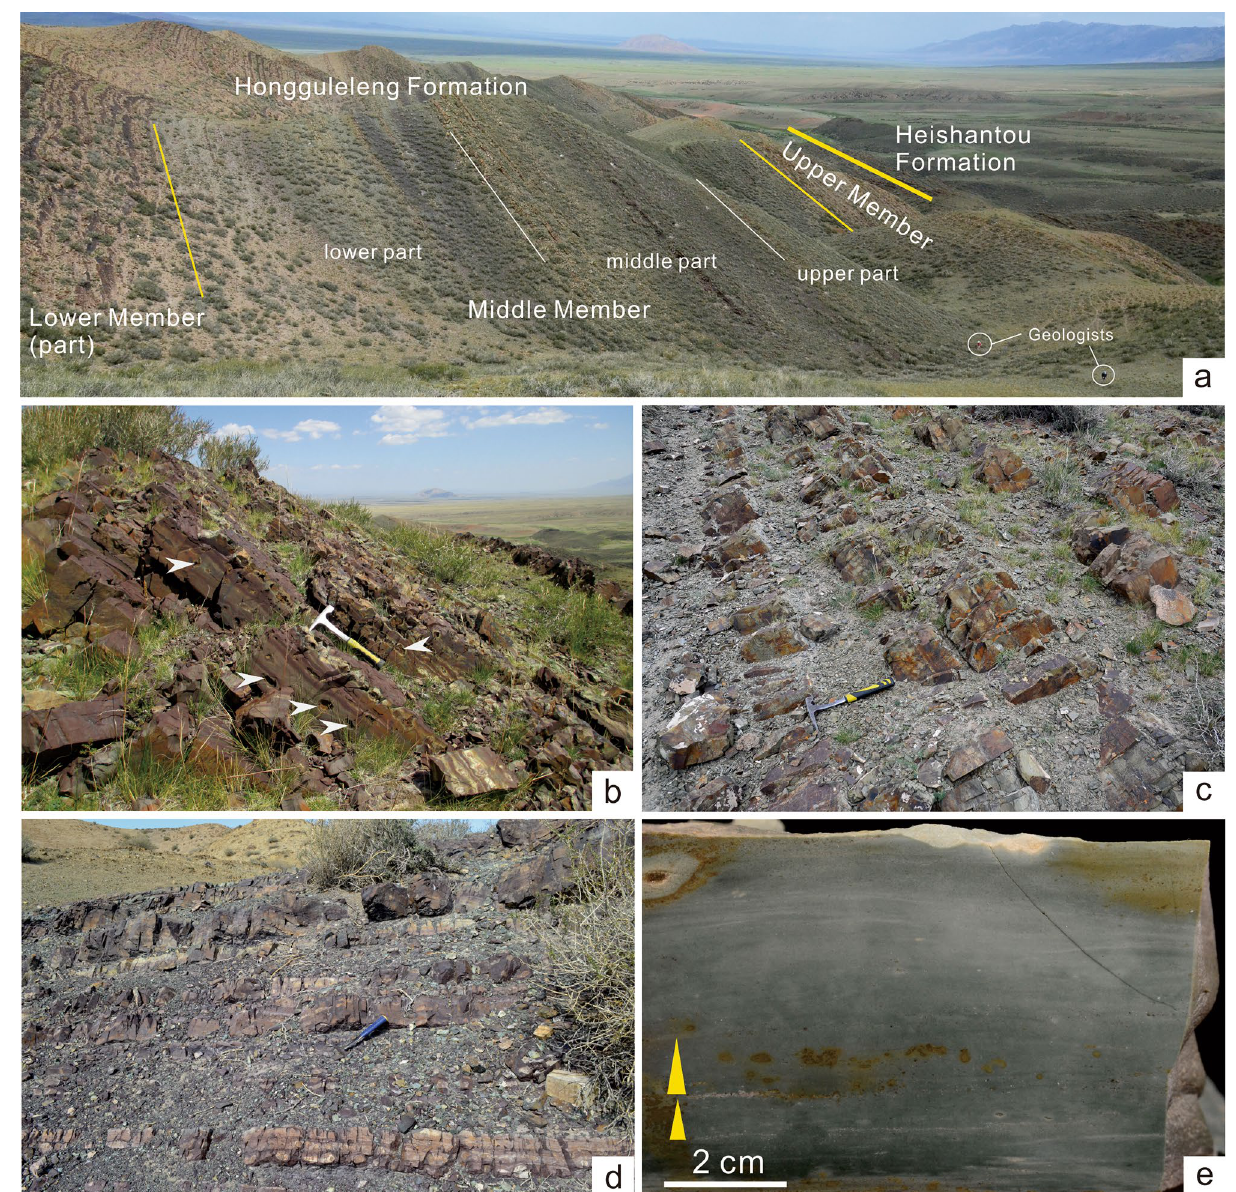
Figure 4. Characteristics of the lithological assemblage in the Middle Member of the Hongguleleng Formation in Western Junggar. ( a ) Outcrop of the Middle Member of the Hongguleleng Formation in the Wulankeshun section. ( b ) Tuffites with calcareous agglomerates, which are easily weathered and leave various shapes of pits in the longitudinal section of the rocks (at the white arrows). ( c , d ) Thin- to middle-bedded tuffites in the middle part of the MHF. ( e ) Longitudinal section of the tuffites, showing small grained bedding in the lower part and horizontal bedding in the upper clymenia fauna) 23 , and even co-occurring with the trilobites (Fig. 3d). Radiolarians and sponge spicules can also be observed in rock thin sections. 18 . In addition, some of the layers in the middle part of the MHF contain trace fossils of the blurred Teichichnus ichnofabric, which suggests a deeper water environment 24 . However, trace fos- sils are rare or absent in the beds where trilobites are enriched, reflecting the fact that trilobites are buried in an environment with little bioturbation. Comparison with Omegops sp. A in the upper part of the LHF. The upper part of the LHF in the same area also contains abundant Omegops sp. A in the bioclastic limestones, argillaceous limestones, and shales assemblage (Fig. 1e). The preservation pattern observed in the upper part of the LMF is distinctly different from that of the middle part of the MHF, with the former containing many fossilized carcasses with articulated or enrolled exoskeletons (Fig. 1f) in addition to exuviae in the same beds, and a rough estimate of the ratio of car- casses to exuviae is 1:5 to 1:10; however, this ratio is less than 1:100 in the latter. Further, the fossil assemblages